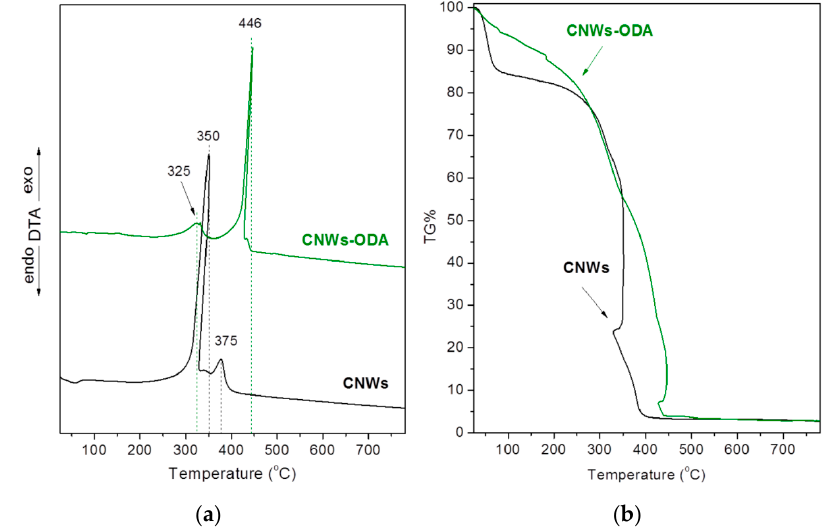
Figure 2. Differential thermal (DTA) ( a ) and thermogravimetric analysis (TGA) ( b ) curves of CNWs and CNWs-ODA samples.